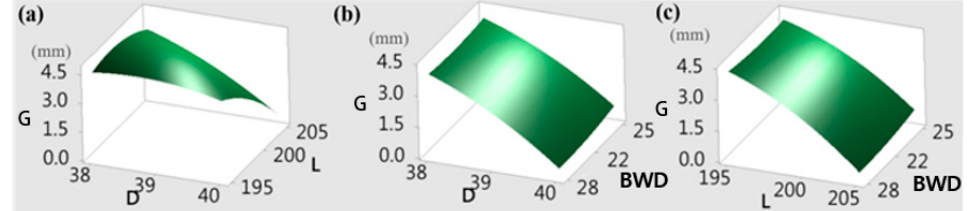
Figure 6. RSM analysis results for minimum gap (G) between the top die and the bottom die ( a – c